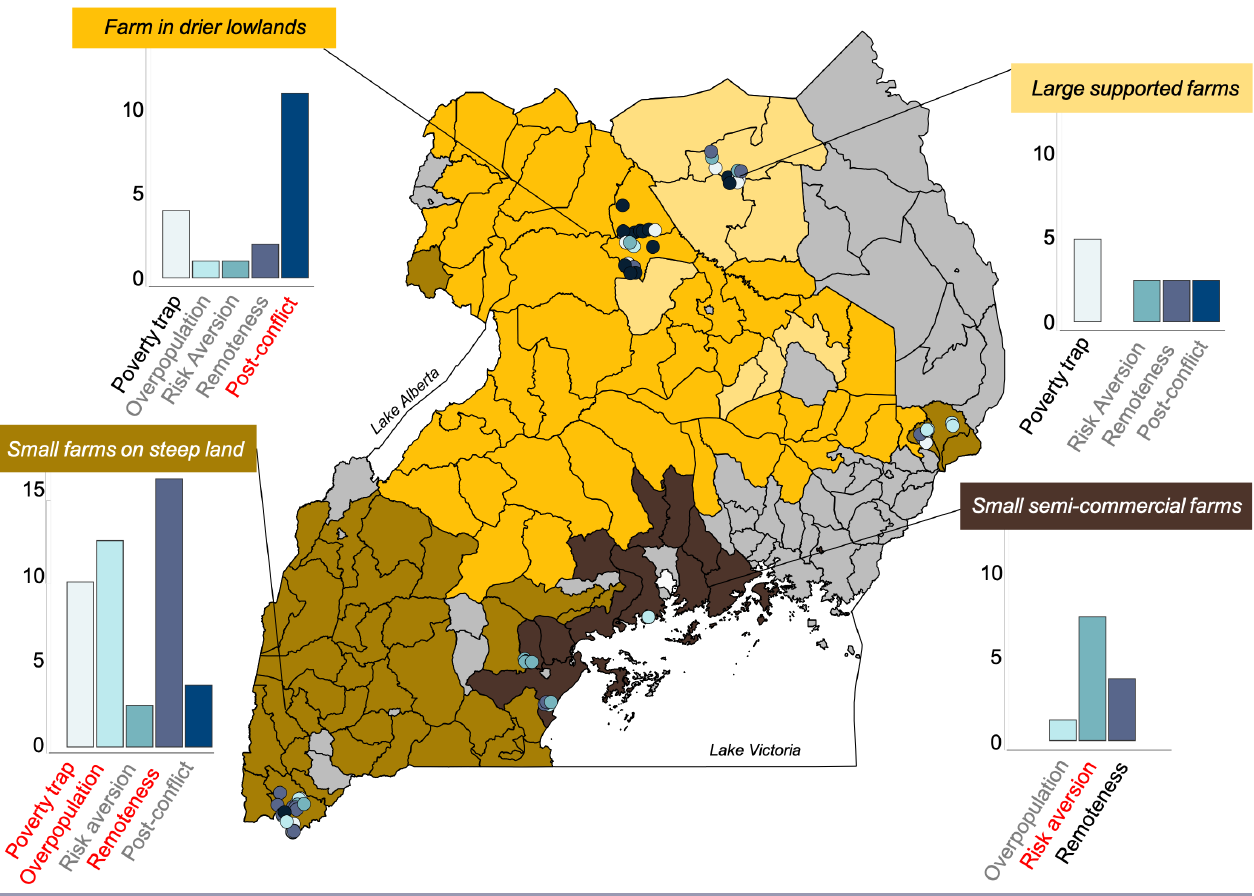
Fig. 6. Combined cognitive and spatial archetypes. Bar plots show the distribution of the five cognitive archetypes (number of interviews on the vertical axes) on the four spatial archetypes hosting interviews. The most relevant cognitive archetypes in a region are in red font, the second most relevant ones are in black, and the least relevant ones are in gray font. Interview locations are shown as colored dots on the map. Grey districts = the three spatial archetypes that did not host